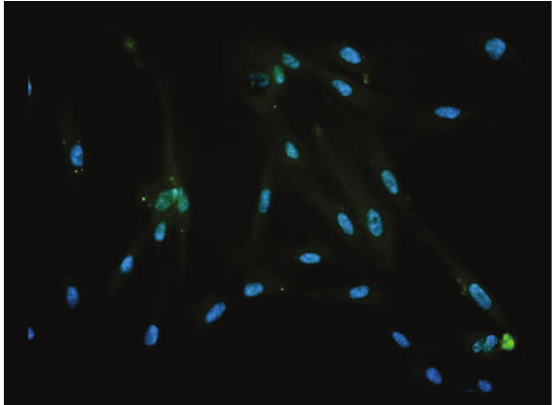
Figure 2. Immunofluorescence of fibroblasts obtained from oral biopsy of periodontal gingival tissue in normal male subject, PARP-1 protein green fluorescence, nuclei were counter-stained in blue with 100 ng/mL 4,6-diamidino- 2-phenylindole (DAPI).